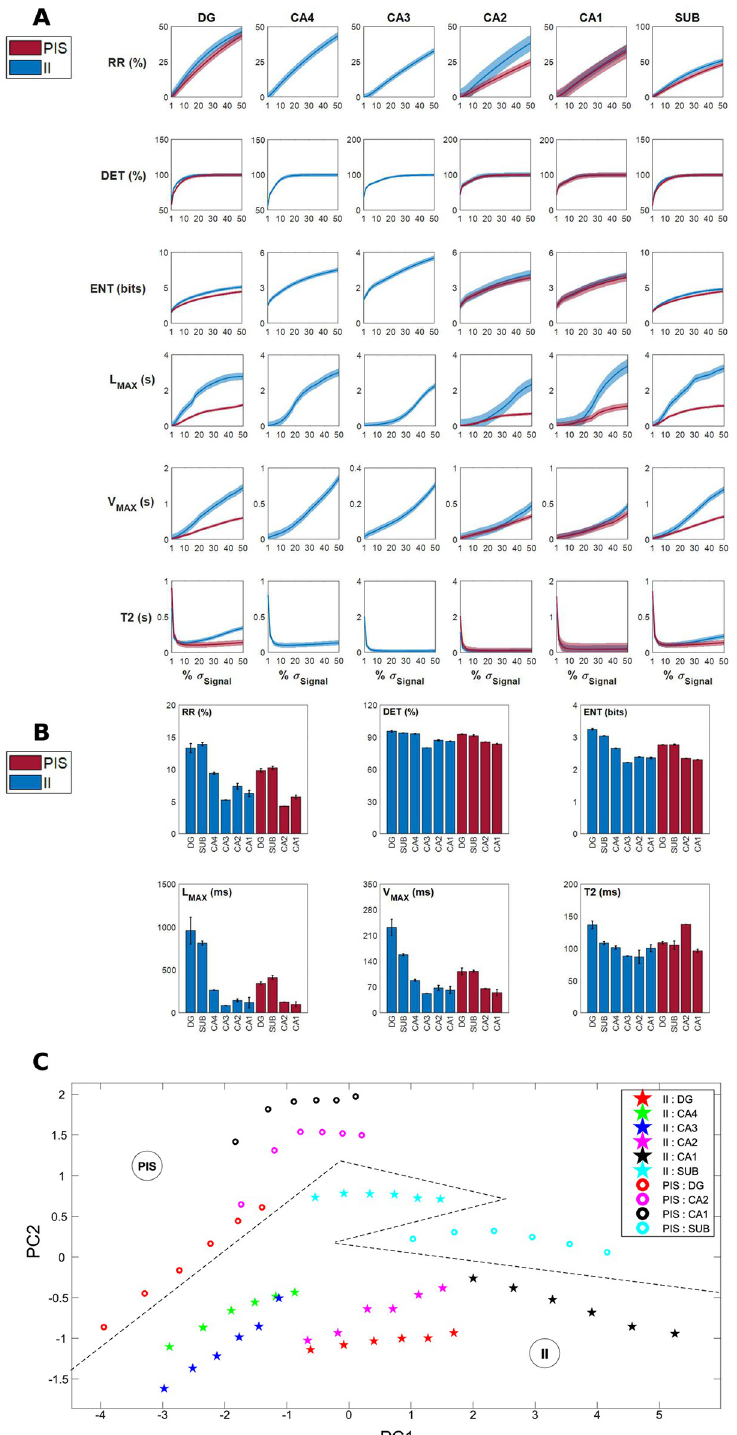
Fig 7. Dynamical particularities of II and PIS activities of each hippocampal subfield. (A) RQA factors in function of the recurrence threshold ( � ) for each hippocampal subfield. The line represents the mean value and the shaded region represents the confidence interval of the mean. (B) Mean values of the RQA factors in each hippocampal subfield for a recurrence threshold of 10% of each electrophysiological recording standard deviation. Error bars indicate SEM. (C) PCA analysis applying � of 10% to 15% of each electrophysiological recording standard deviation.